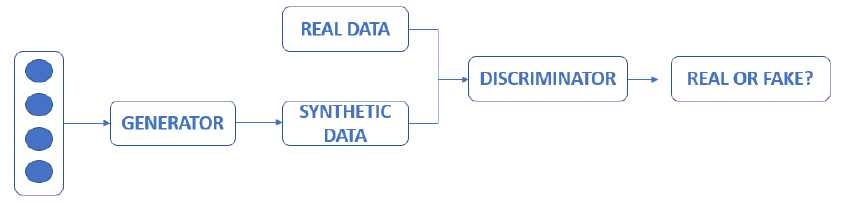
Figure 6. Representation of a GAN.